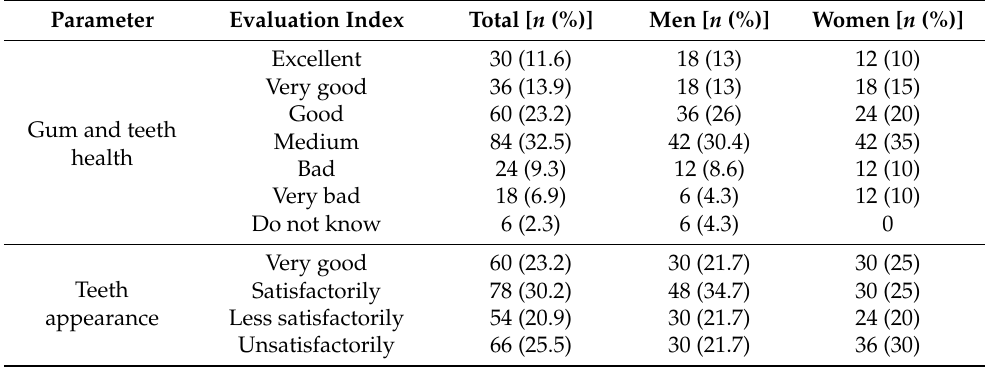
Table 1. Patients’ self-perceptions of oral health